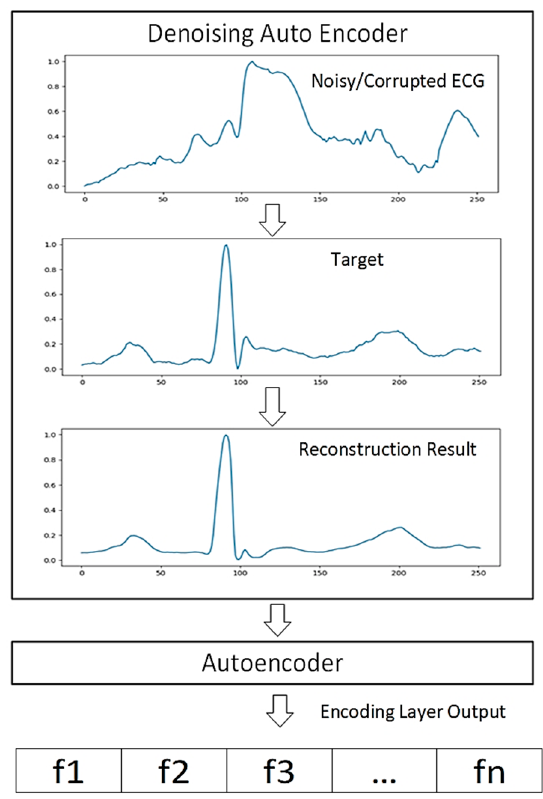
Figure 7. The sample of the stacked DAEs–AEs process for ECG signal.